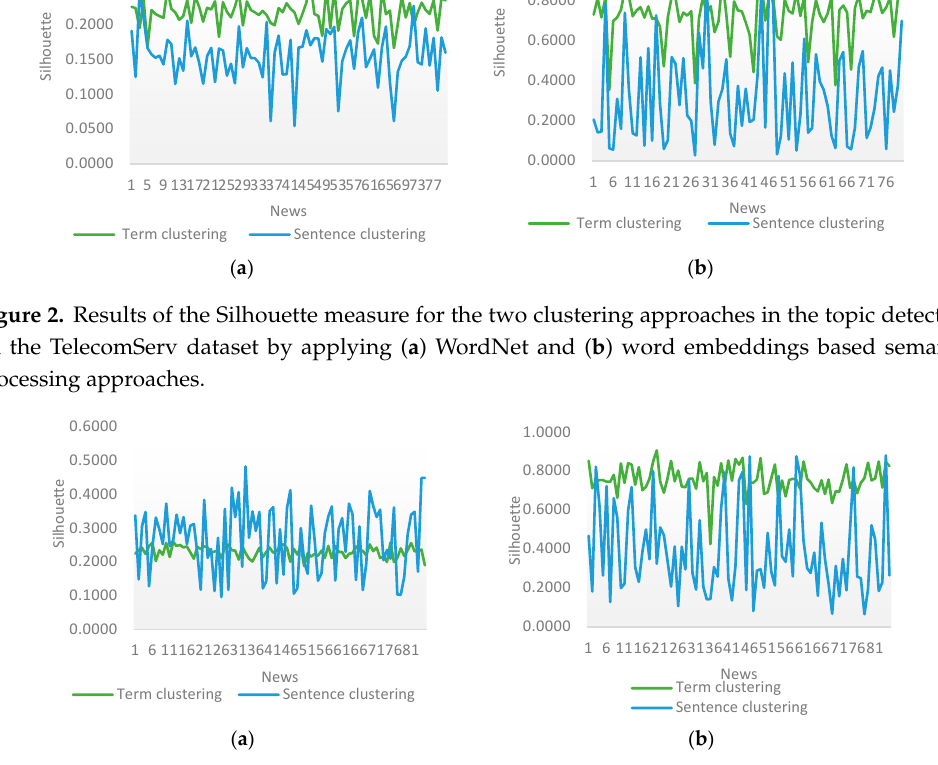
Figure 3. Results of the Silhouette measure for the two clustering approaches in the topic detection on COVID-19 dataset by applying ( a ) WordNet and ( b ) word embeddings based semantic processing approaches.